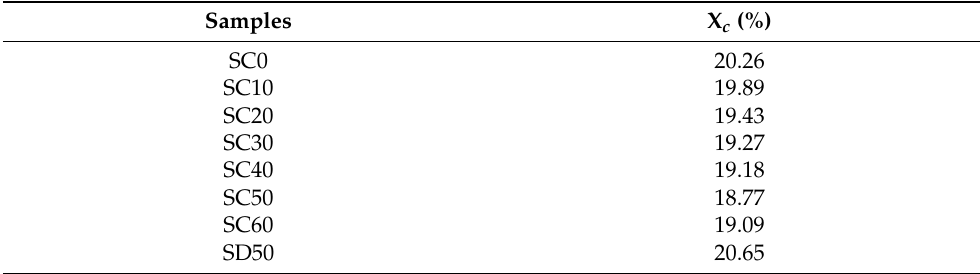
Table 1. Degree of crystallinity of MC/PC/K 3 PO 4 /glycerol